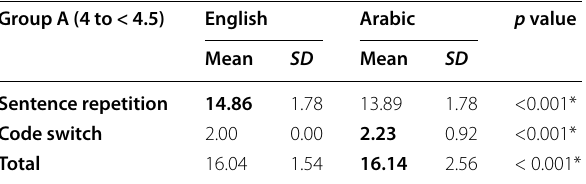
SD standard deviation, bold: higher value, *significant p value < 0.05